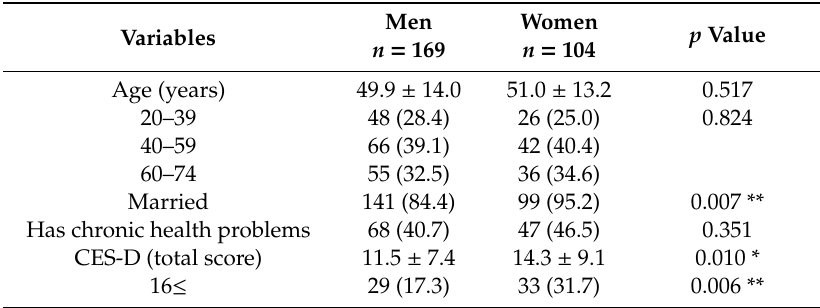
Table 2. Patient characteristics by